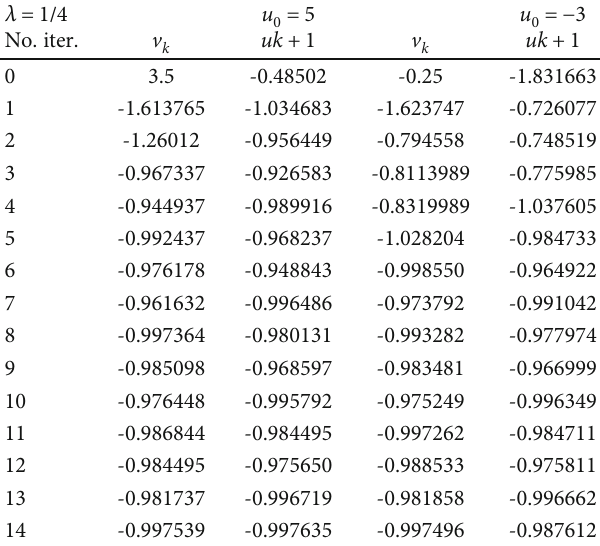
Table 1: Computation of iterative sequences of Iterative Scheme 8 for the choices of parameters λ = 1/4 and α = 1/3 k and di ff erent n = 5 and u = − 3 initial points u 0 0